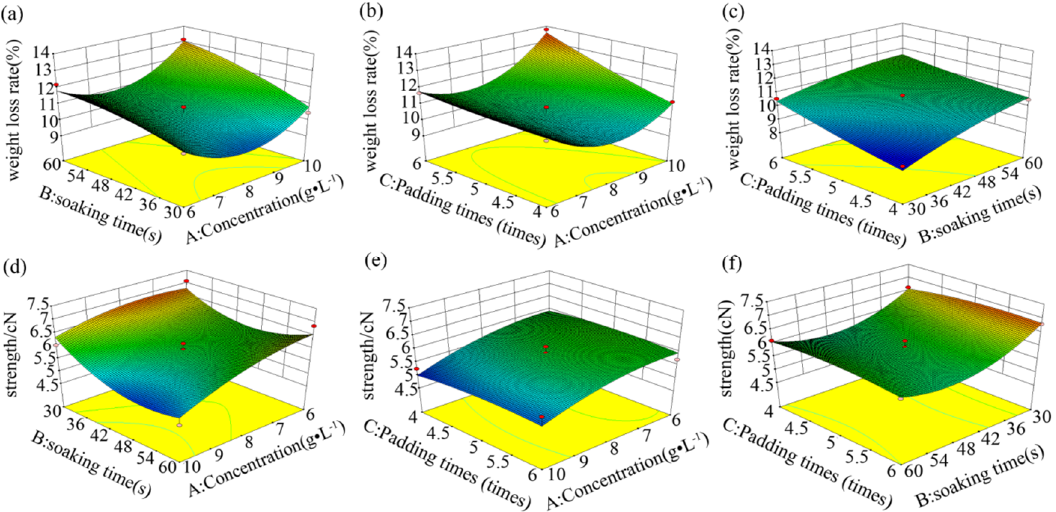
Figure 3. Response surfaces of the factor interaction relationships for the weight loss rate ( a – c ) and breaking strength ( d – f